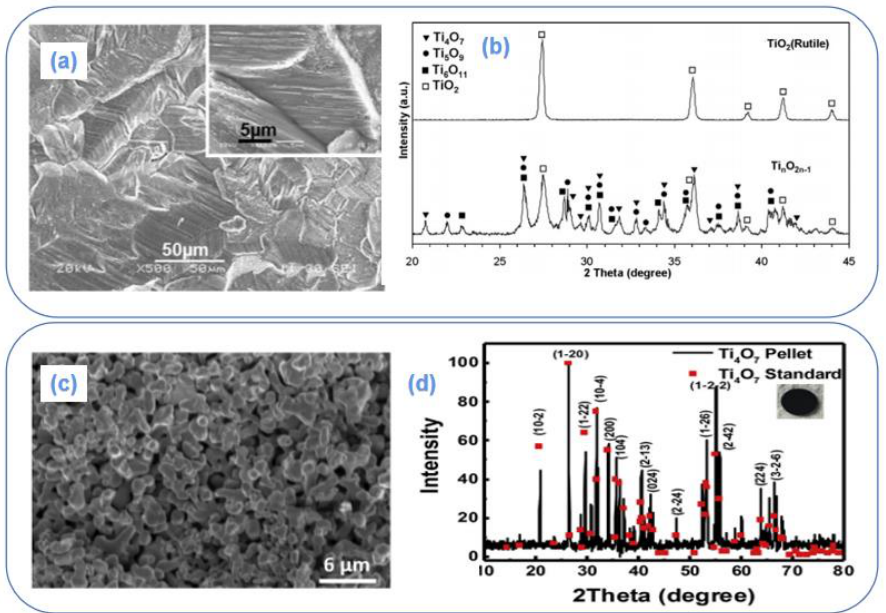
Figure 5. XRD pattern of compression reduction method [84] ( a ); SEM image of compression reduc- tion method [84] ( b ); XRD pattern of powder sintering method [60] ( c ); SEM figure of powder sintering electrode [60] ( d ).